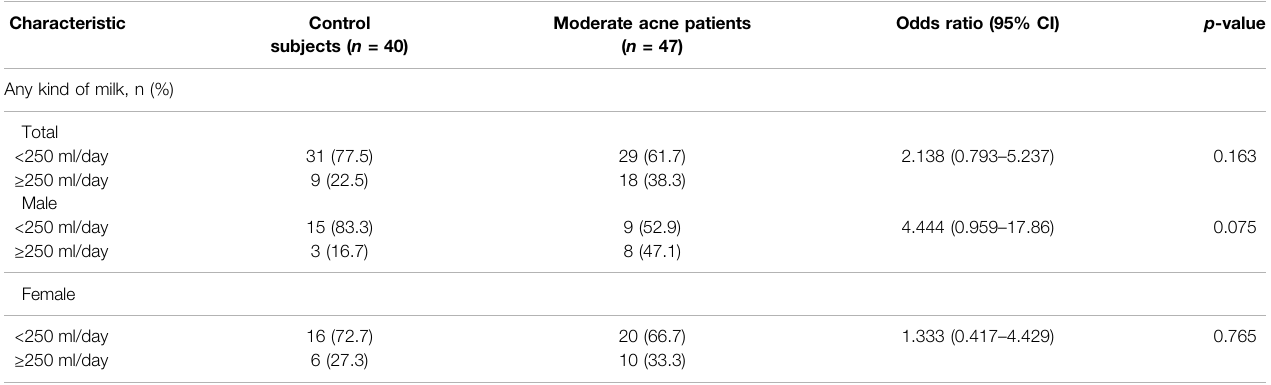
TABLE 3 | Categorical analysis of milk consumption and acne.